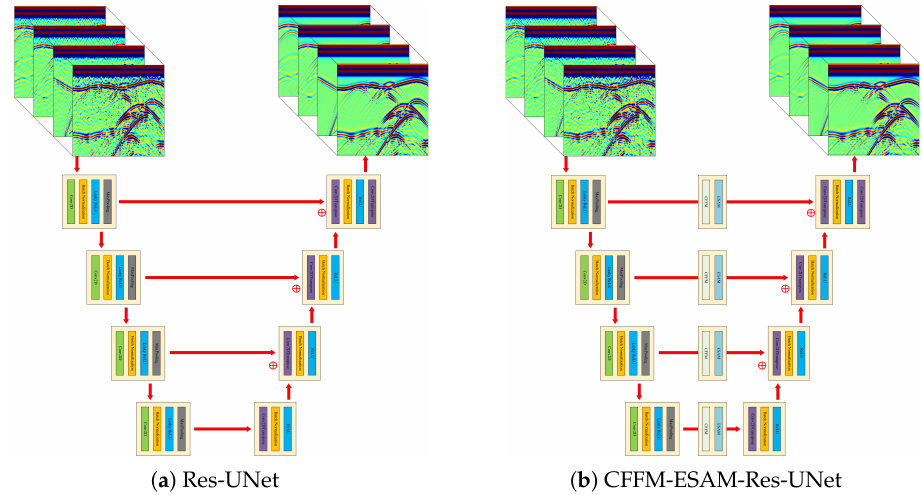
Figure 5. The structure of the deep learning network.